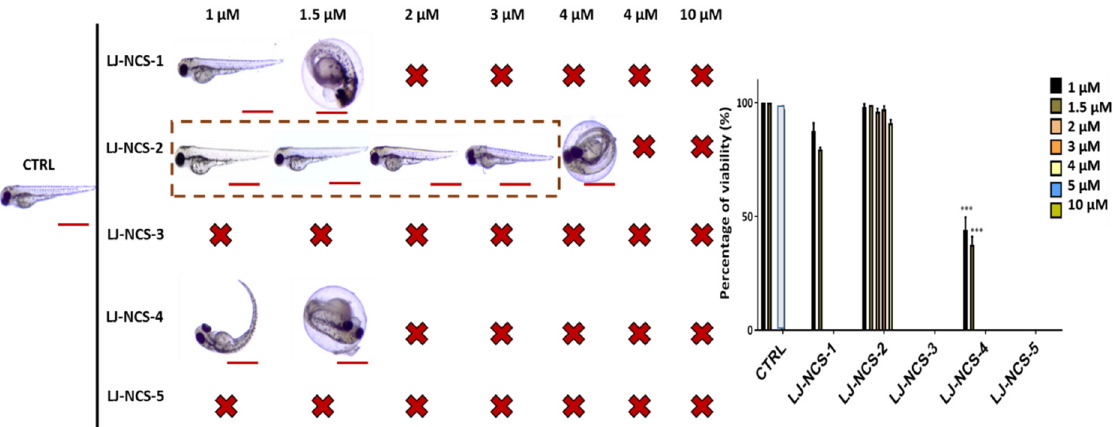
Figure 7. The effects of 72 h isothiocyanates treatment on morphology and mortality of 6 hpf zebrafish embryos at the experiment starting point. Representative images of embryos exposed to 1–10 µM of LJ-NCS-1–5 (n = 3 replicates, 50 embryos per replicate); bar scale = 950 µm. Percentage of viability-data are represented as mean ± SD; *** p < 0.001.